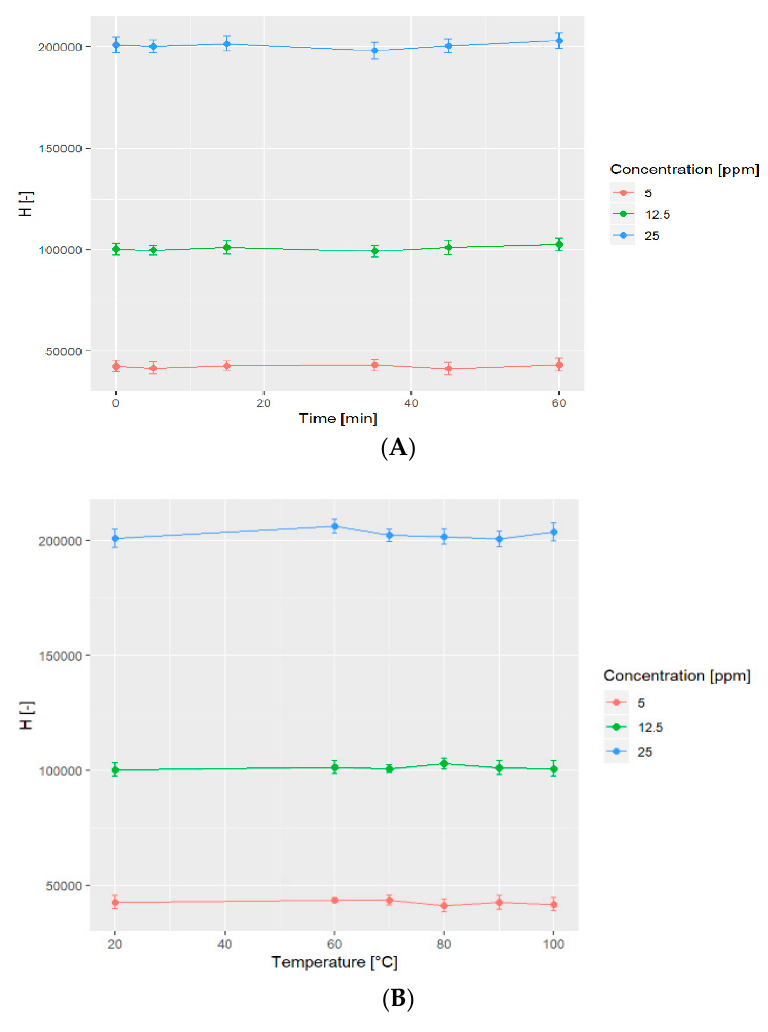
Figure 6. Influence of time of heating at 100 °C ( A ) and temperature of sample heating for 15 min; ( B ) the height (H) of the nitrate peak.